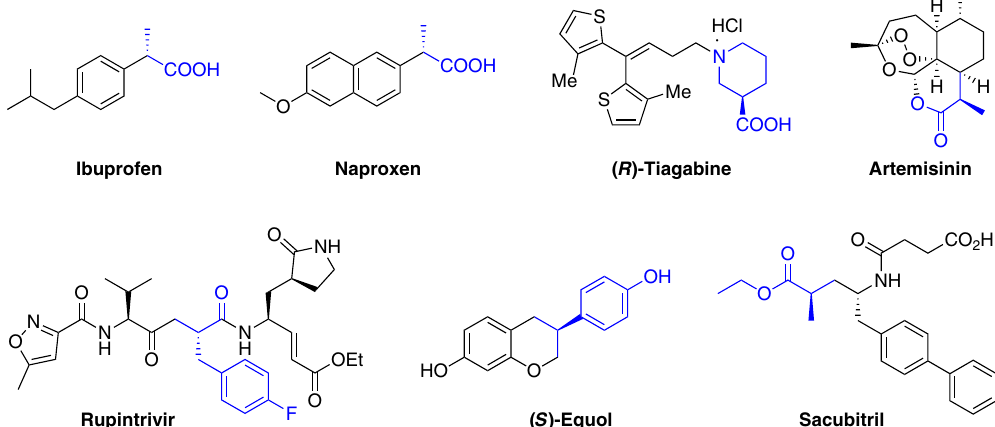
Fig. 1. Chiral carboxylic acids such as Ibuprofen, Naproxen 1,2 , and ( R )-Tiagabine 3 are well-known drugs. The key intermediates